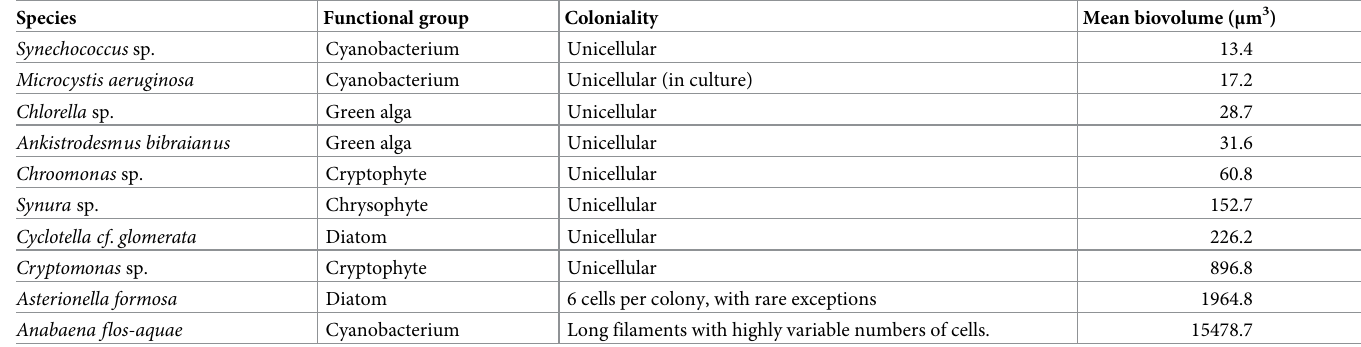
Table 1. Cultures used in biovolume estimation. Mean biovolume values of these cultures were estimated by microscopy as part of this